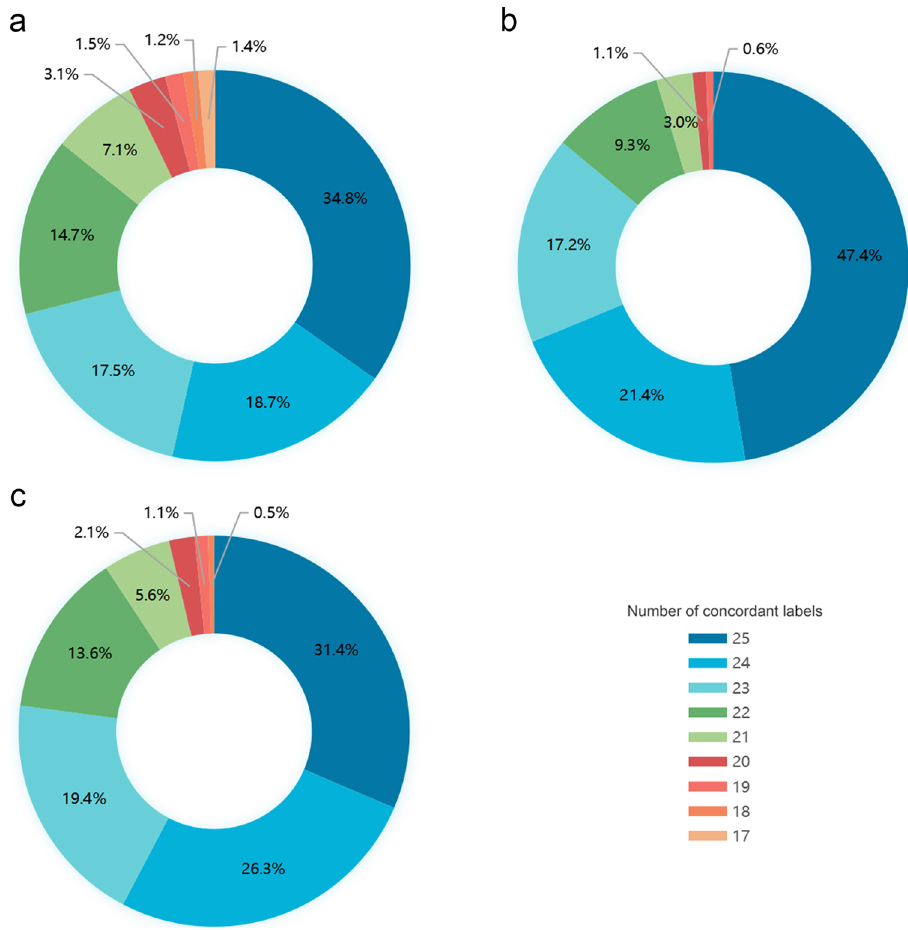
Fig. 4 Number and percentage of concordant labels between the convolutional neural network (CNN) and expert consensus reading in the three test cohorts. a In the cohort of symptomatic patients in the academic hospital, 2092 patients (34.8%) showed consistency on 25 signs between CNN and the consensus reading, and 1121 (18.7%), 1049 (17.5%), and 881 (14.7%) patients showed consistency on 24, 23, and 22 signs, respectively. Overall, CNN correctly classi fi ed ≥ 22 (88%) abnormal signs in 5142 patients (85.8%). b In the cohort of asymptomatic screening examinees in the academic hospital, 1010 (47.4%), 456 (21.4%), 366 (17.2%), and 198 (9.3%) patients showed consistency on 25, 24, 23, and 22 signs between CNN and the consensus reading, respectively. Overall, CNN correctly classi fi ed ≥ 22 signs in 2030 (95.3%) patients. c In the cohort of symptomatic patients in eight community clinics, 566 (31.4%), 474 (26.3%), 350 (19.4%), and 245 (13.6%) patients showed consistency between CNN and the consensus reading on 25, 24, 23, and 22 labels, respectively. Overall, CNN correctly classi fi ed ≥ 22 (88%) abnormal signs in 1636 (90.7%)